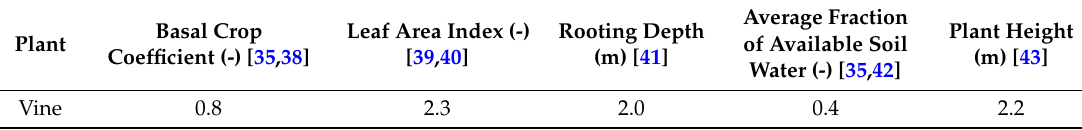
Table 4. Plant coefficients used to calculate crop